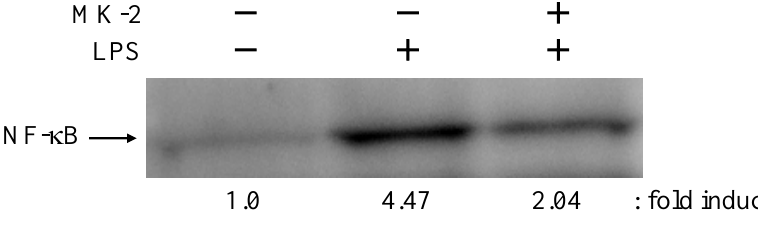
Figure 5. Inhibitory effects of MK-2 on nuclear translocation of NF-θB in RAW264.7 cells. The cells were incubated with 10 κM MK-2 (+) or DMSO (−), as a vehicle control for 30 min, and then with 100 ng/mL LPS for 30 min. Nuclear proteins were prepared from the cells and subjected to Western blot analysis for evaluation of the nuclear translocation of NF-θB p65. The intensity of each band was analyzed, and the values relative to treatment without LPS (negative control, taken as 1.0-fold) are represented at the lower edge of the image.